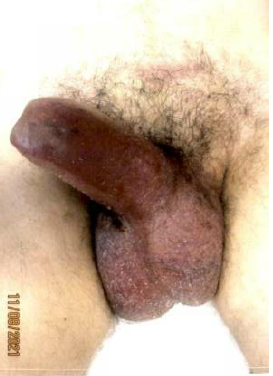
Figure 1. Priapism at two weeks post-neoadjuvant chemoradiation.